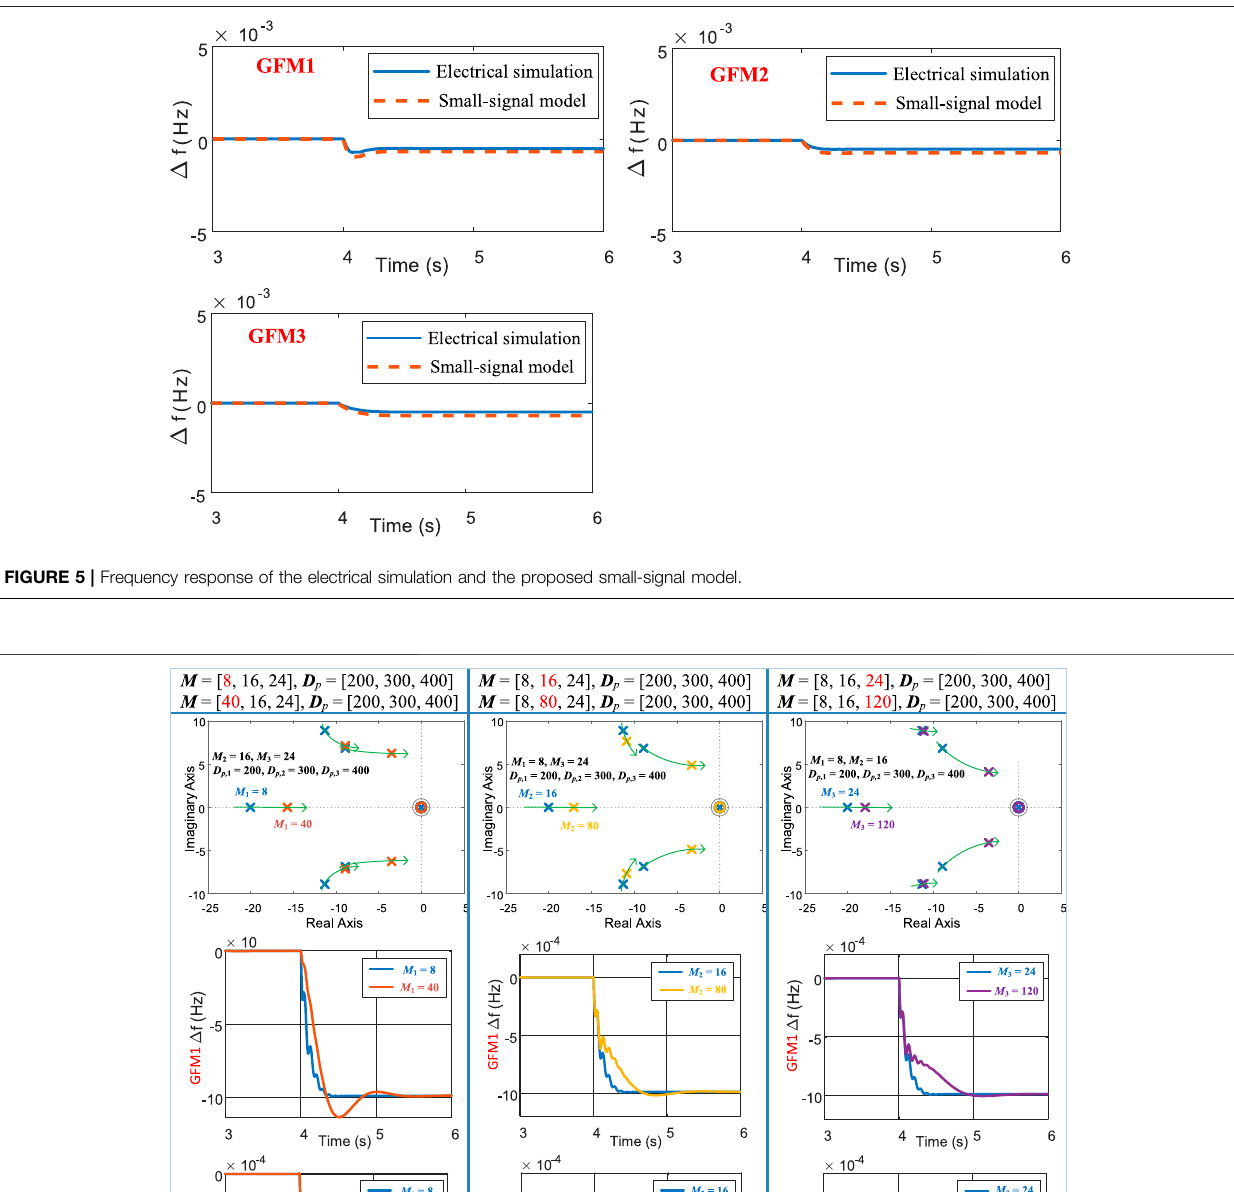
Frontiers in Energy Research |